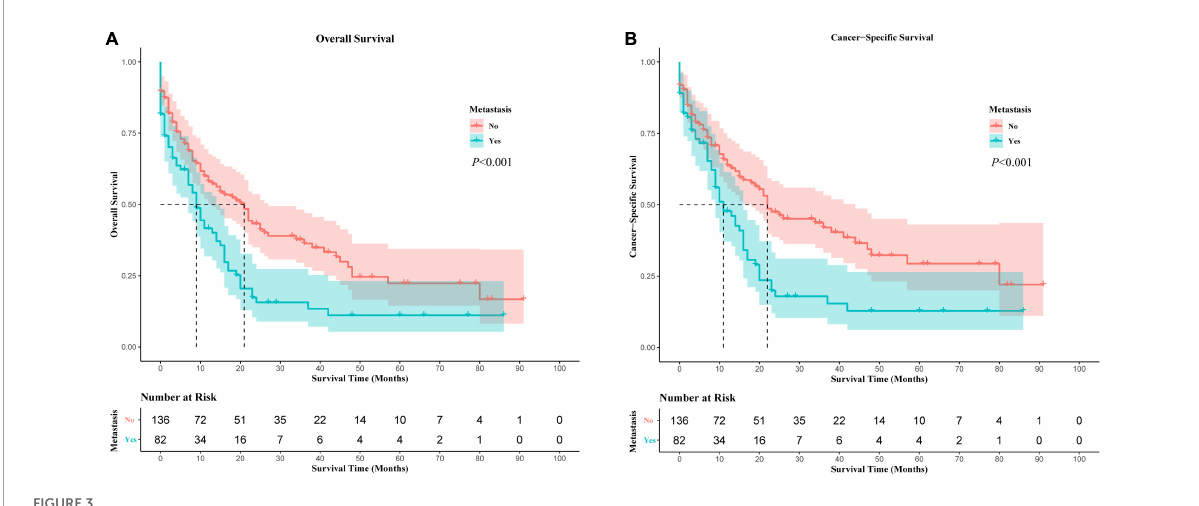
FIGURE3 The prognostic impacts of distant